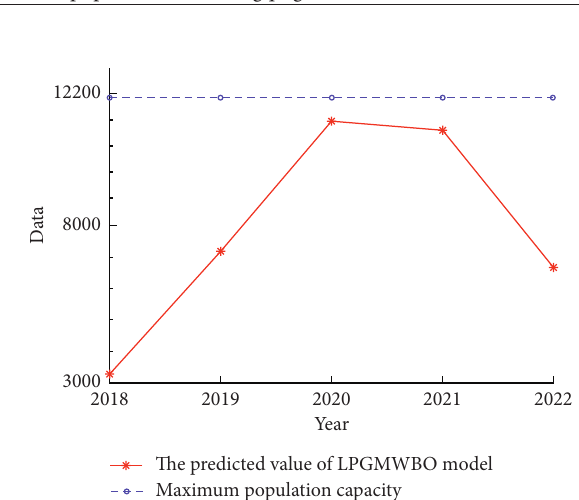
Figure 7: Population forecast trends for the urban population